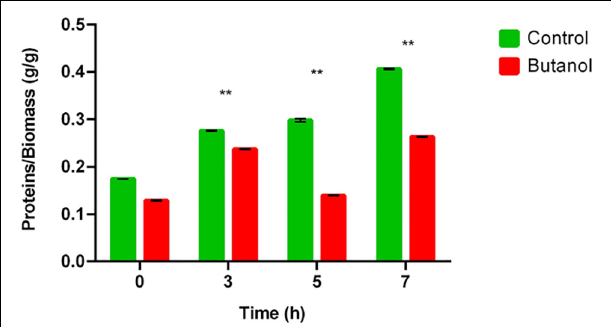
FIGURE 5 | Protein content of cells grown in control (green) or butanol-supplemented medium (red) in different growth phases. Data are the mean of triplicate measurements. Asterisks indicate values that significantly (** p -value < 0.01) differ between the two growth